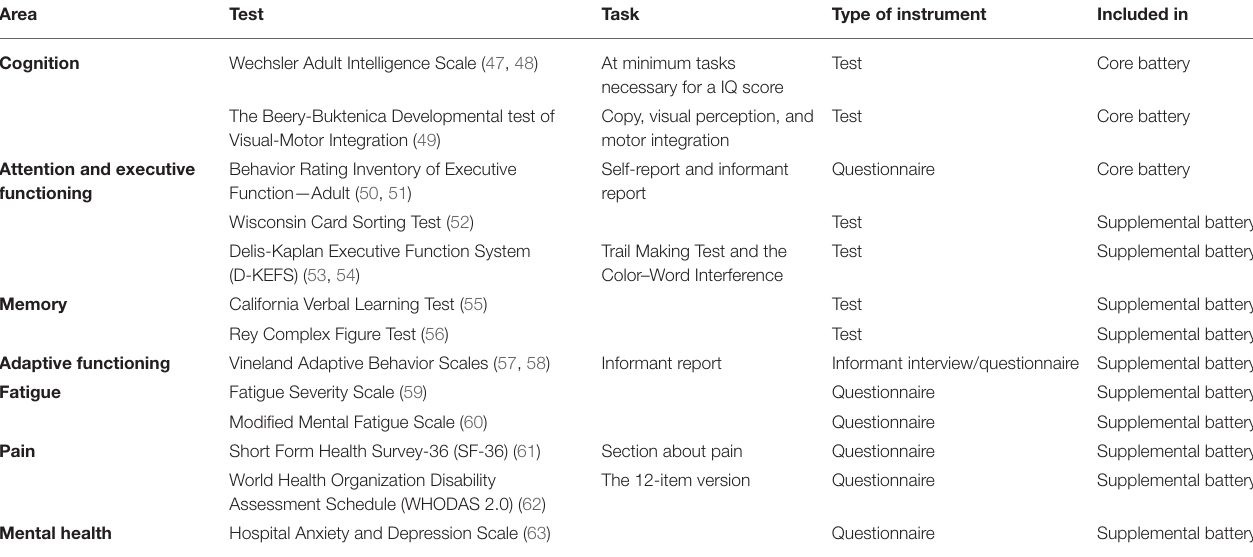
TABLE 1 | Instruments in the CP Cog -Adult for assessing cognition and adaptive functioning: core battery (recommended for all) and supplemental tests (administered on indication).